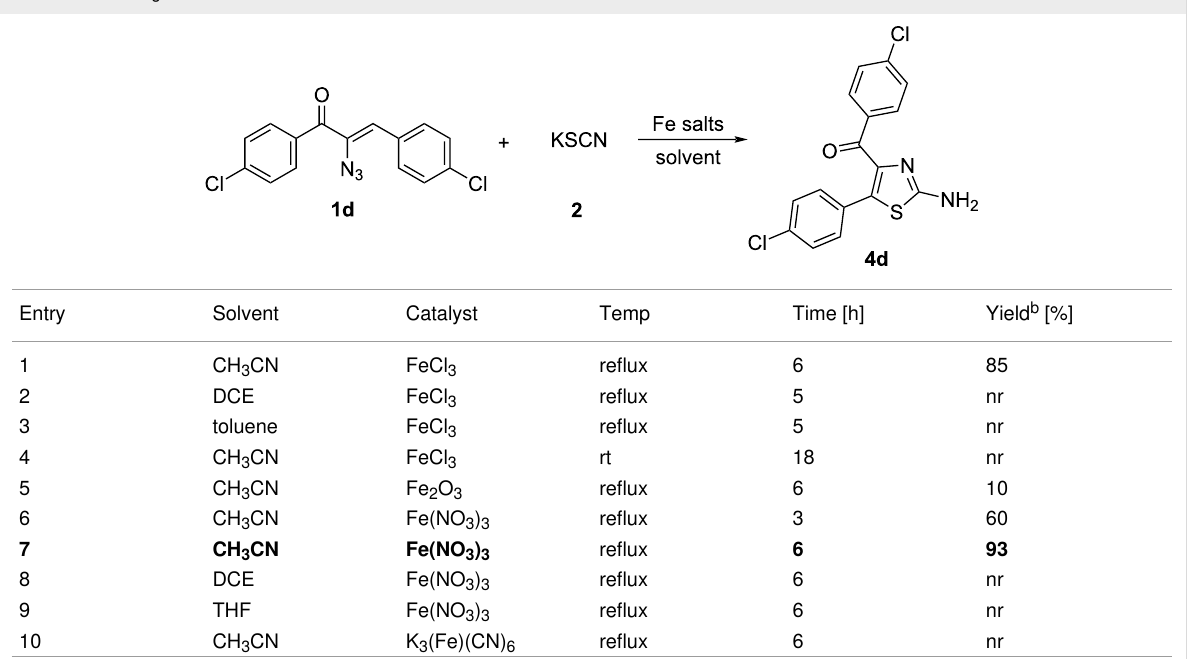
Table 2: Screening of iron salts and solvents a